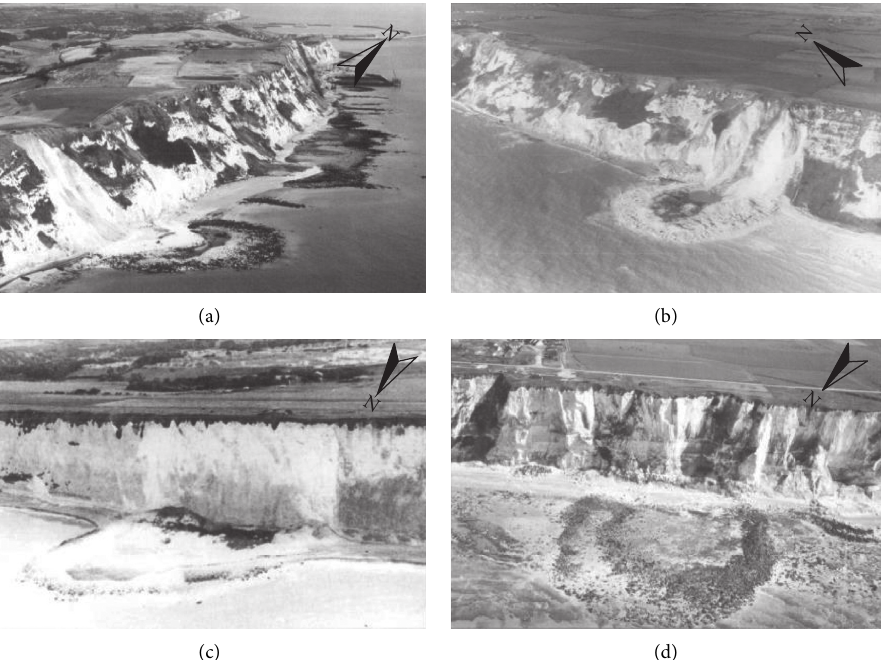
Figure 9: Topography of typical flowslides. (a) and (b) located in Folkestone Warren (51 ° 05 ′ 03 ″ N 1 ° 20 ′ 36 ″ E), (c) and (d) located Dover,